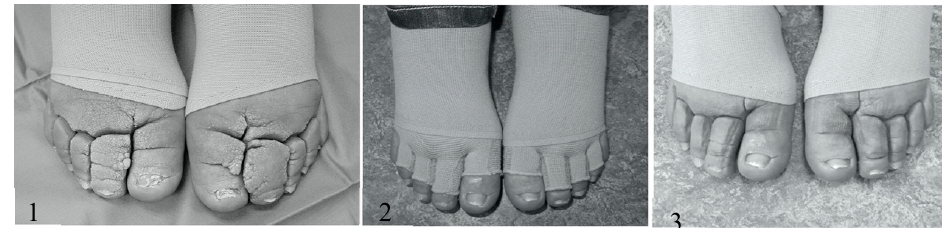
Figure 2. Procedure of excision and reconstruction in FOXC2 lymphedema: ( 1 ) preoperatively, ( 2 ) after 12 weeks with toecaps, and ( 3 ) result after 12 weeks.